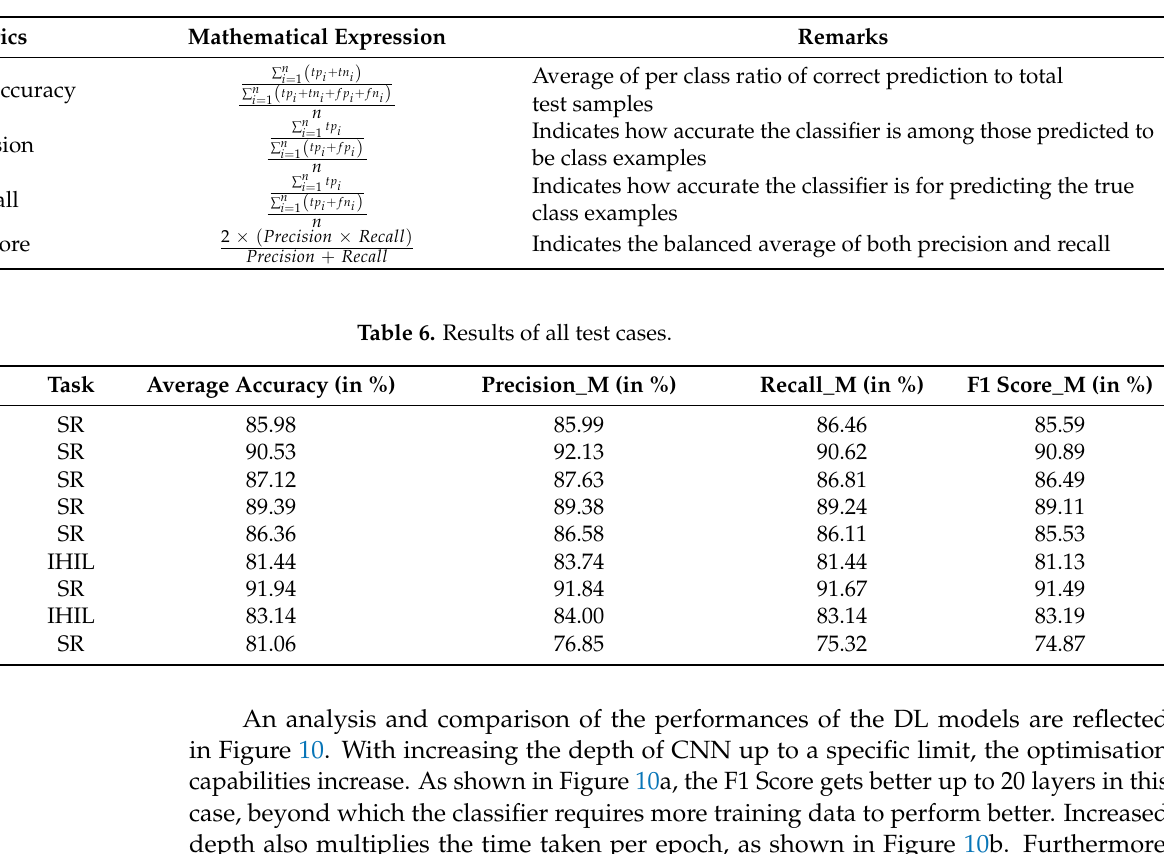
Table 5. Performance metrics used for analysing the performance of the classifiers.